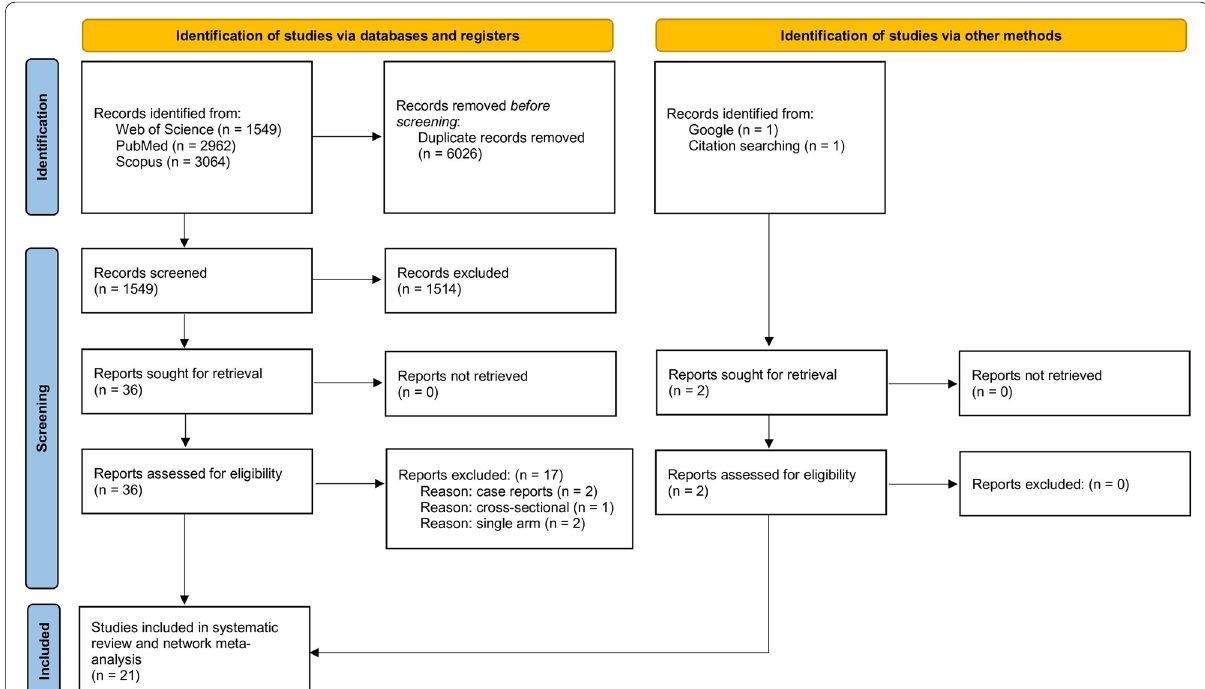
Fig. 1 PRISMA (Preferred Reporting of Items in Systematic Reviews and Meta-Analysis) flowchart depicting the identification, screening, and inclusion of the studies included